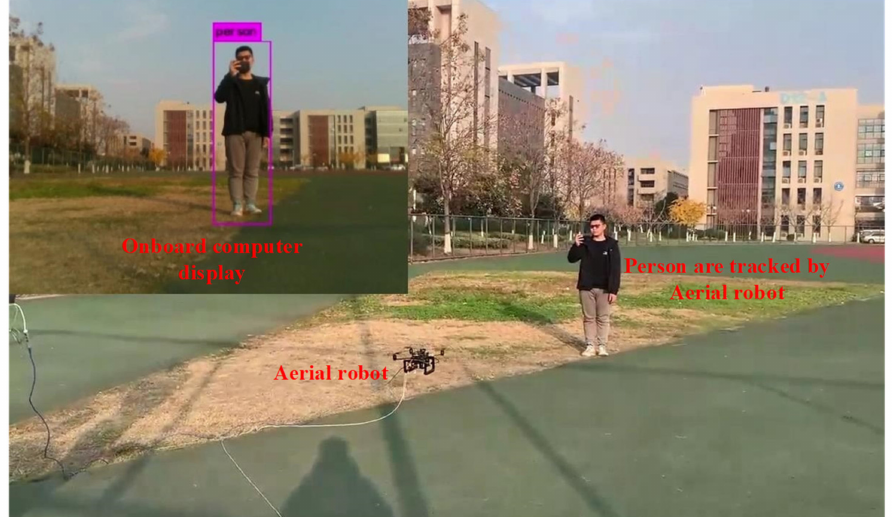
Figure 12. The real-world tracking test was conducted on a university playground. The com- plete video is available at: https://www.bilibili.com/video/BV1cb4y1v7cX?share_source=copy_web (19 December